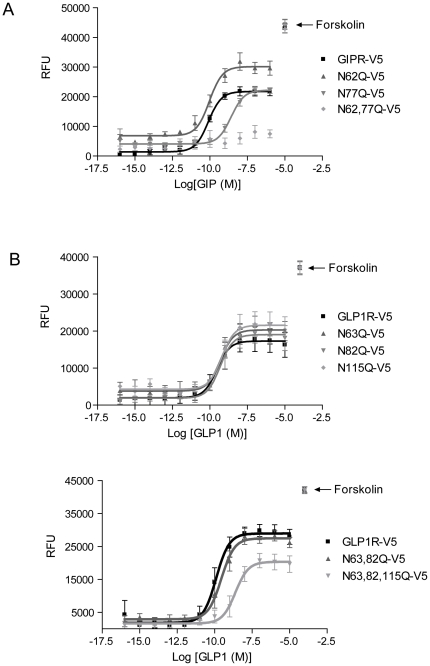
Sensitivity and efficacy of GIP and GLP-1 actions on cAMP production in CHO cells are enhanced by N-glycosylation of their receptors.Plots of Relative Fluorescence Units (RFU) versus log of concentration of GIP (A) or GLP-1 (B). RFU values were determined by FRET assay which was carried out using CHO cells expressing GIPR or GLP-1R constructs as indicated. Forskolin was used to control for variations in total cell number. Mean data ± SE (performed in duplicate for an n = 5 separate transfections) at each ligand concentration were plotted, converted to a logarithmic scale, and fitted using a sigmoidal dose-response curve.